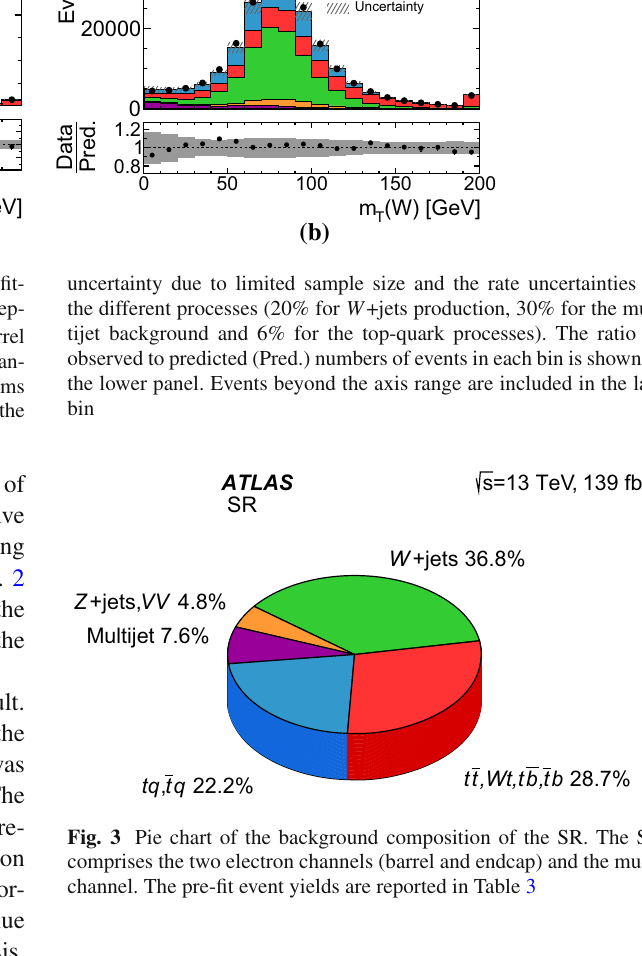
The three largest backgrounds are W +jets production, the ¯ b background, and tq combined t ¯ t - tW - t